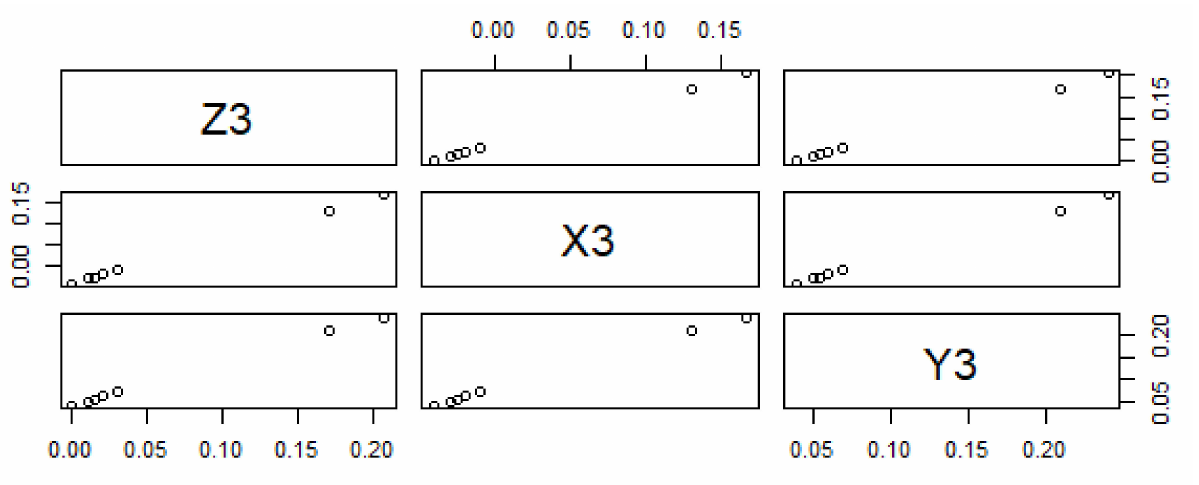
Figure 5. Data trending plot between dependent variable Z 2 and predictor variables X 2 and Y 2 with a difference of 0.03 from the experimentally fixed values at 420 ◦ C.